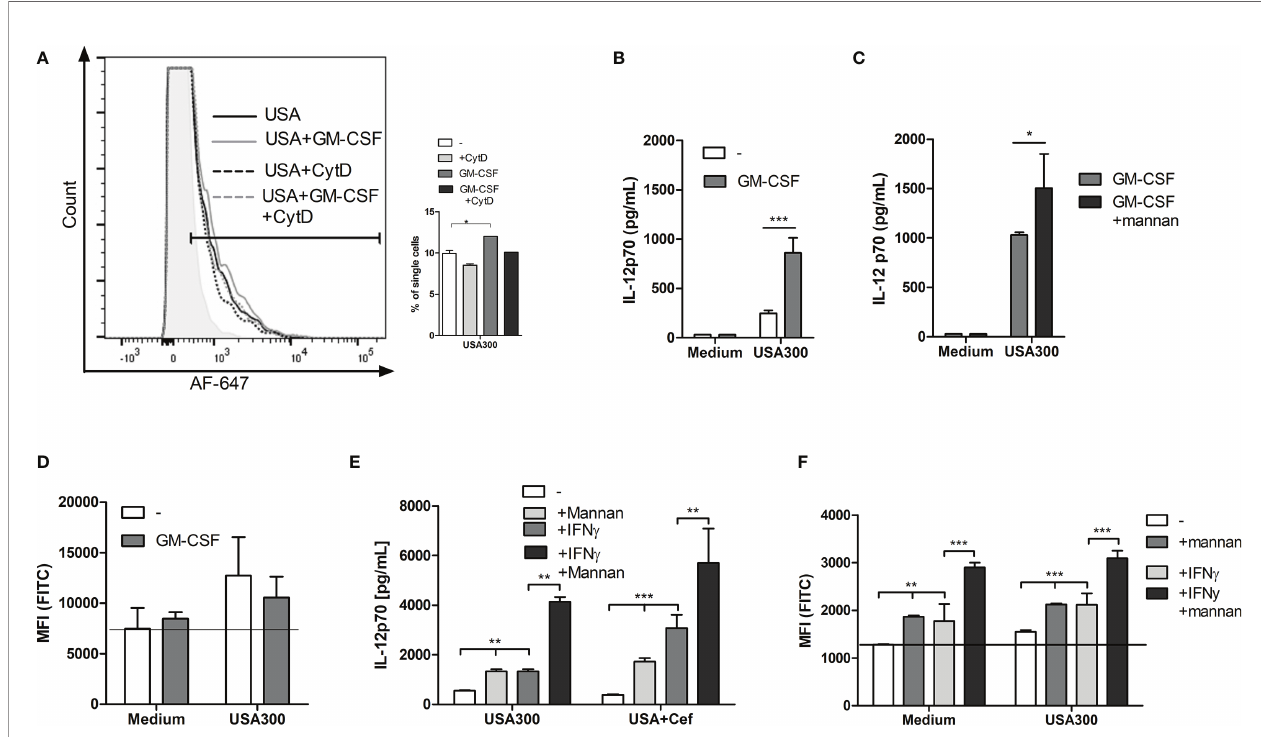
FIGURE 5 | The IL-12 enhancement by mannan is not affected by in fl ammatory conditions. Histograms depict the fl uorescence of AF-647-labelled USA300 in DCs pre-treated or not by GM-CSF and with or without CytD treatment. Bars show the number of fl uorescent cells after each treatment (A) . Cells were treated with GM- CSF and stimulated with USA300 and IL-12 in the supernatant was measured (B) . Cells were treated with GM-CSF and mannan before USA300 stimulation and IL12 production was measured (C) . DCs were incubated with carboxy-H 2 DCFDA with or without GM-CSF and then stimulated with USA300 for 4 h. The oxidation was measured by fl ow cytometry, shown as MFI (D) . DCs were pre-treated with mannan or not for 30 min prior to USA300 stimulation with IFN- g in the medium or not. DCs were incubated with carboxy-H 2 DCFDA with or without IFN- g and then stimulated with USA300 for 4 h. The oxidation was measured by fl ow cytometry, shown as MFI. For all experiments n=3 +/- SD. 2-way ANOVAs were performed for (B – F) , *p < 0.05, **p < 0.01, ***p < 0.001. Data represent one out of at least two